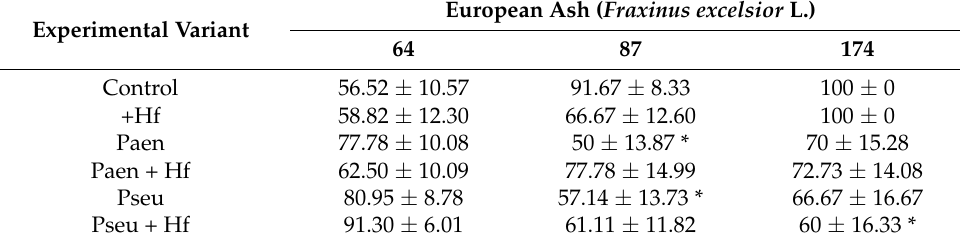
Table 2. Percentage of rooted explants in the in vitro cultures of three Fraxinus excelsior genotypes after second stage of culturing with different microorganisms. In the first stage, the nutrient medium was inoculated with either Paenibacillus sp. (‘Paen’) or Pseudomonas sp. (‘Pseu’) bacteria. For the second stage, explants from each variant were transferred onto fresh medium, either sterile or inoculated with fungus H . fraxineus (‘+Hf’). The control group of explants was cultured on sterile media during both stages.